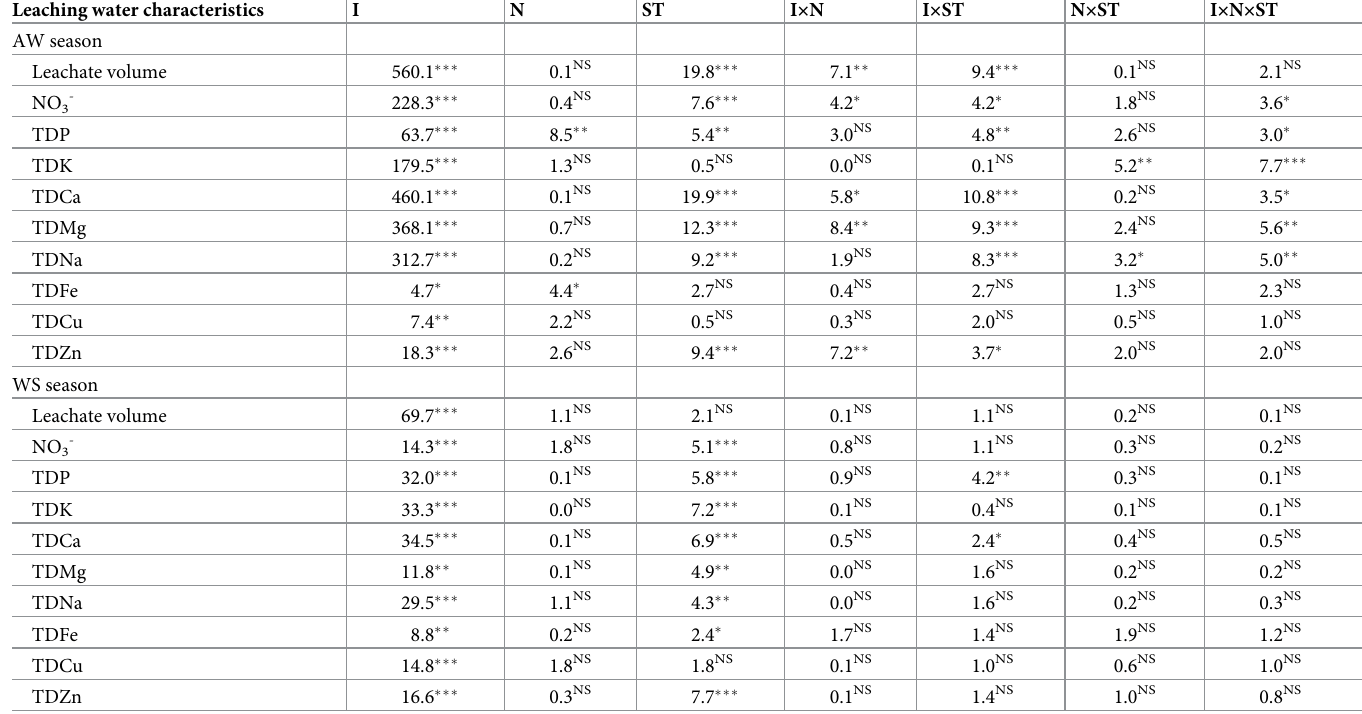
Table 3. Analysis of variance of the effects of irrigation (I), nitrogen fertilization (N) and sampling time (ST) on cumulative leached amounts of mineral elements in leaching water in the autumn-winter (AW) and winter-spring (WS) cropping seasons. Leaching water